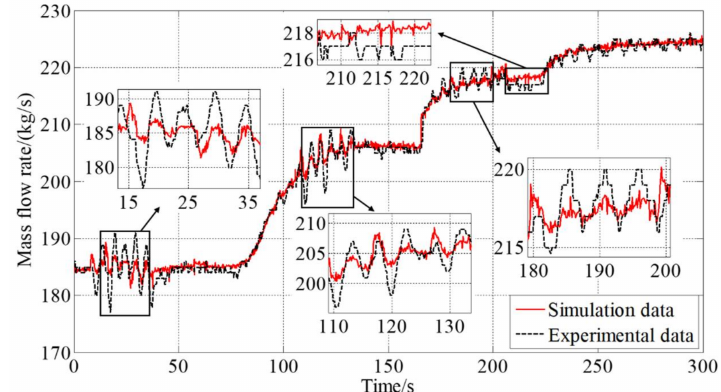
Figure 17. Comparison of outlet flow of variable cross section